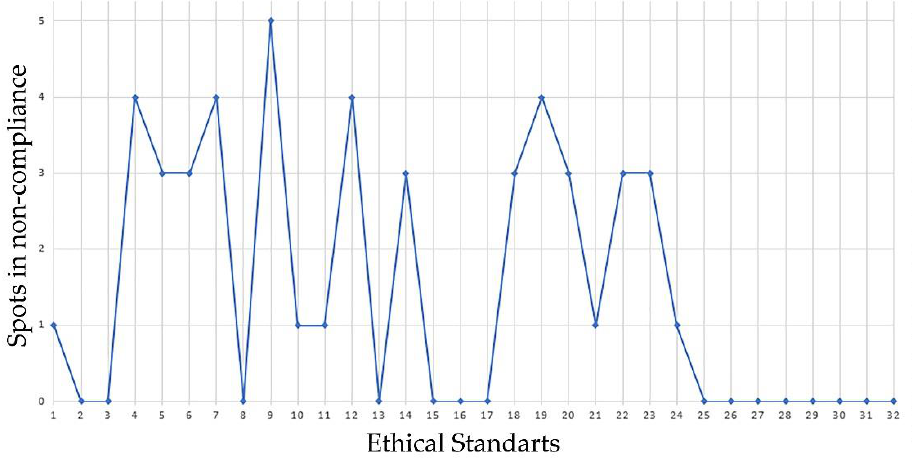
Figure 2. Noncompliance with the general ethical standard in FBA in Spanish TV in 2020.